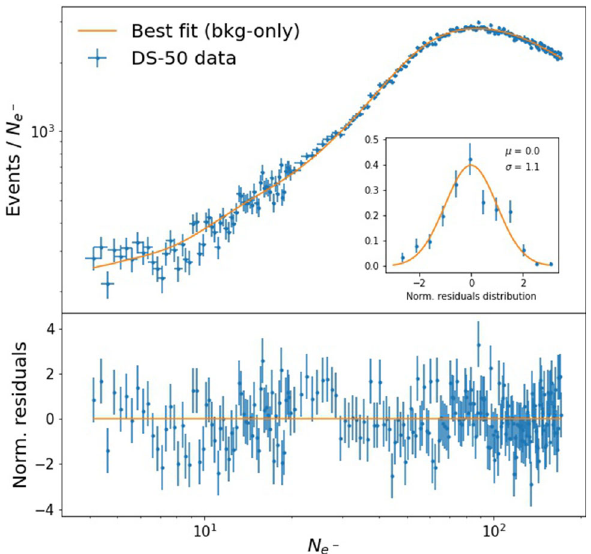
Fig. 8 Top: Best fit (orange line) to the observed dataset (blue points) of the DS-50 experiment. Bottom: Normalized residual (blue points) with respect to the best fit